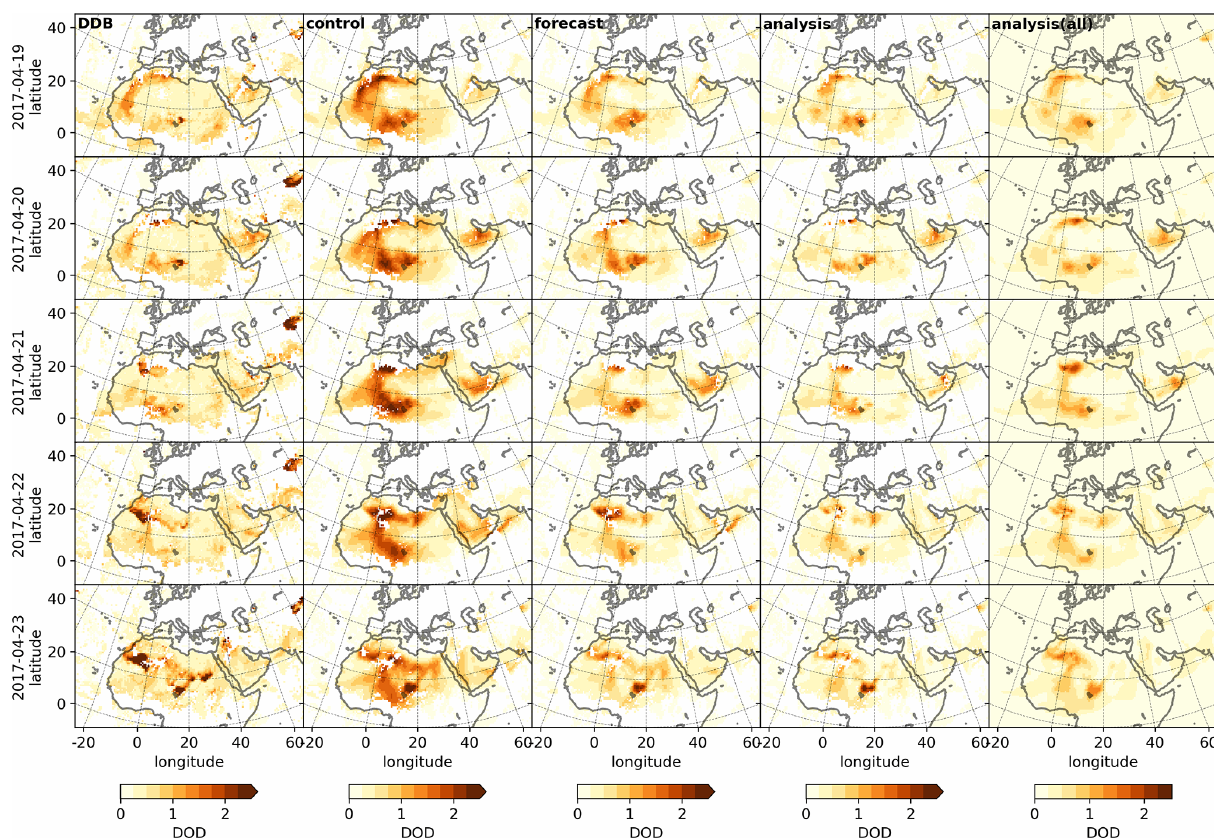
Figure 1. DOD from DDB and model simulations between 19 and 23 April 2017 for the control and eLIVAS experiments. The first four columns show the DOD from DDB (left) and three model simulations of DOD collocated with DDB: control experiment, forecast, and analysis from the eLIVAS experiment. The last column shows the analyses’ daily average without collocation with DDB. Each row represents a different